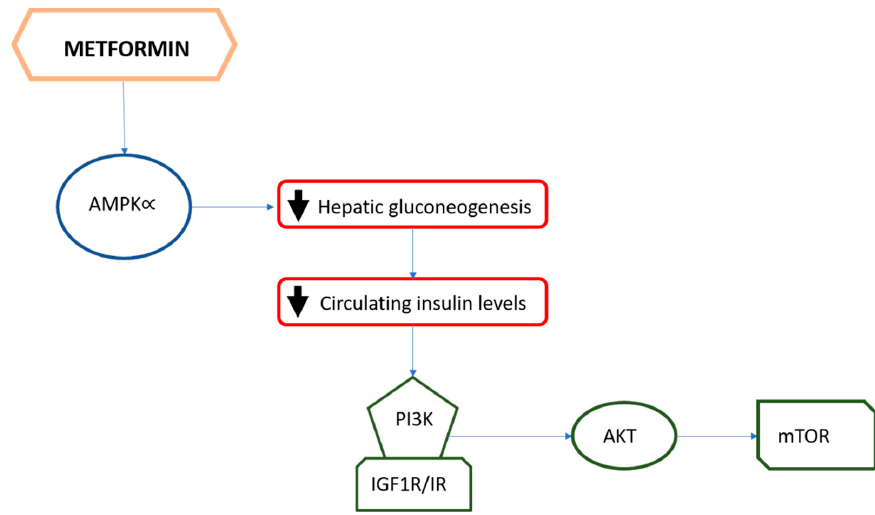
Figure 2. The pathway involved in the indirect effect of metformin in inhibition of cancel cell proliferation through the reduction of insulin/IGF1 axis.